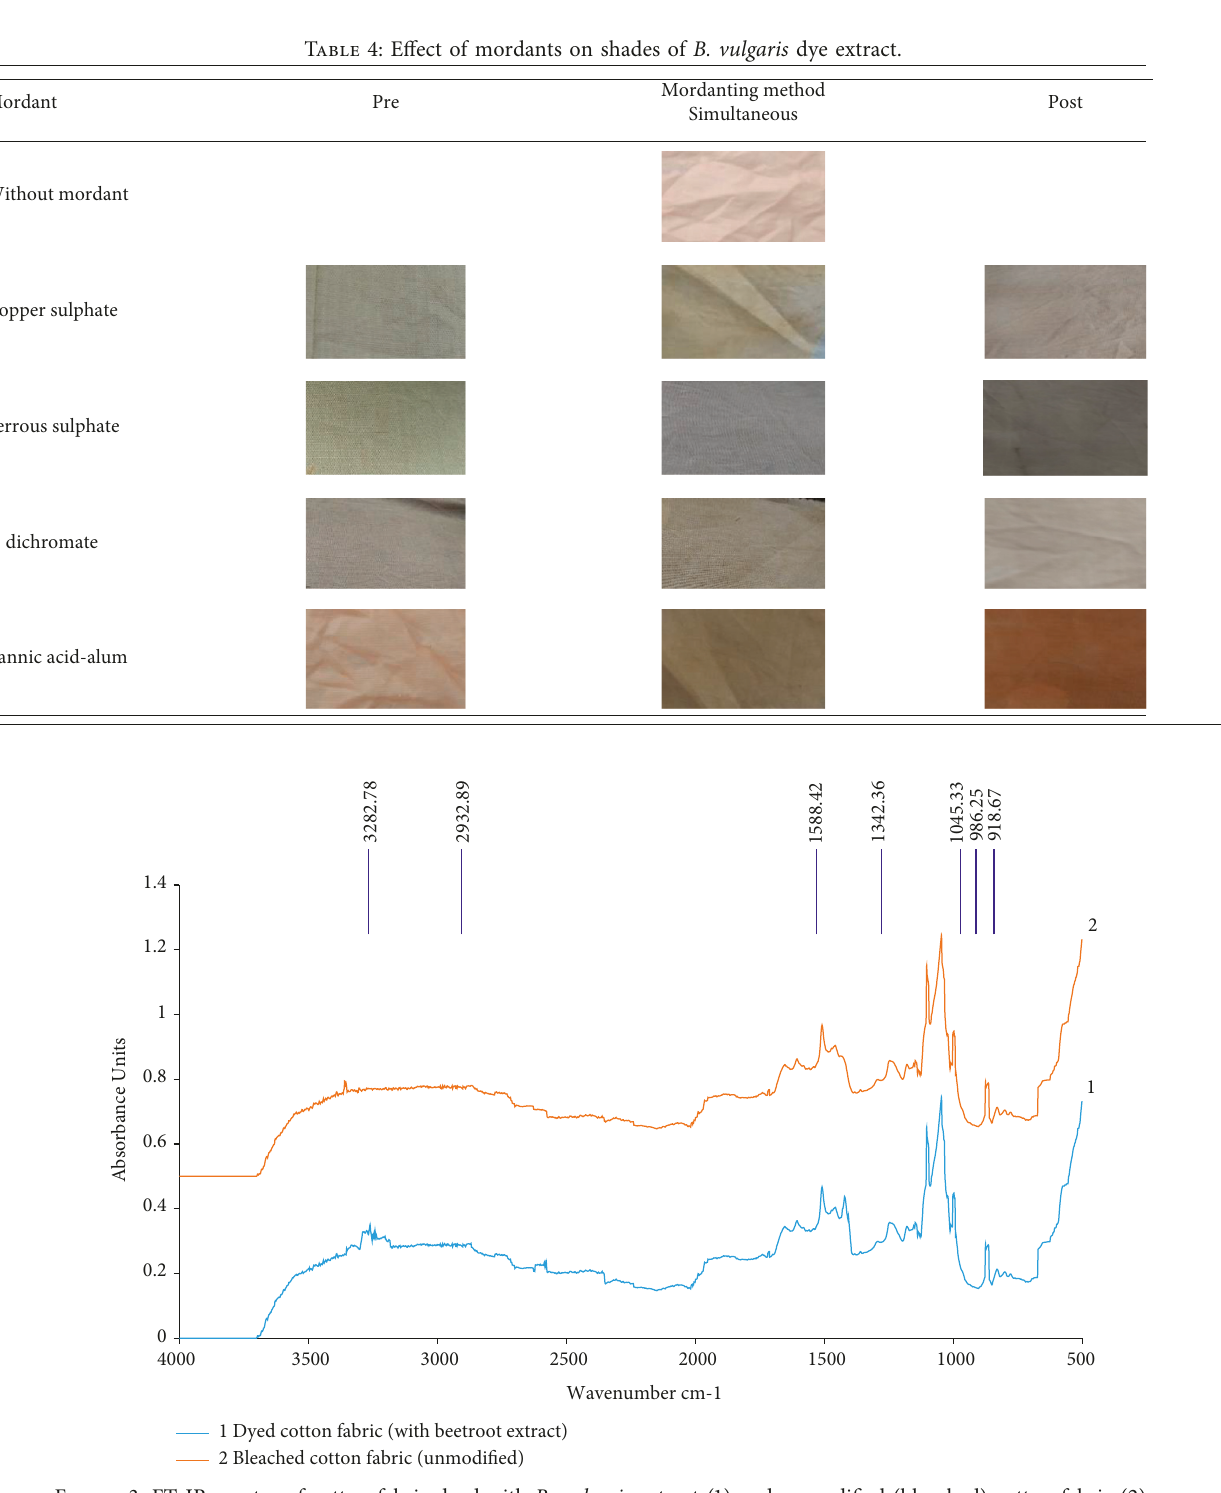
Figure 3: FT-IR spectra of cotton fabric dyed with B. vulgaris extract (1) and unmodified (bleached) cotton fabric